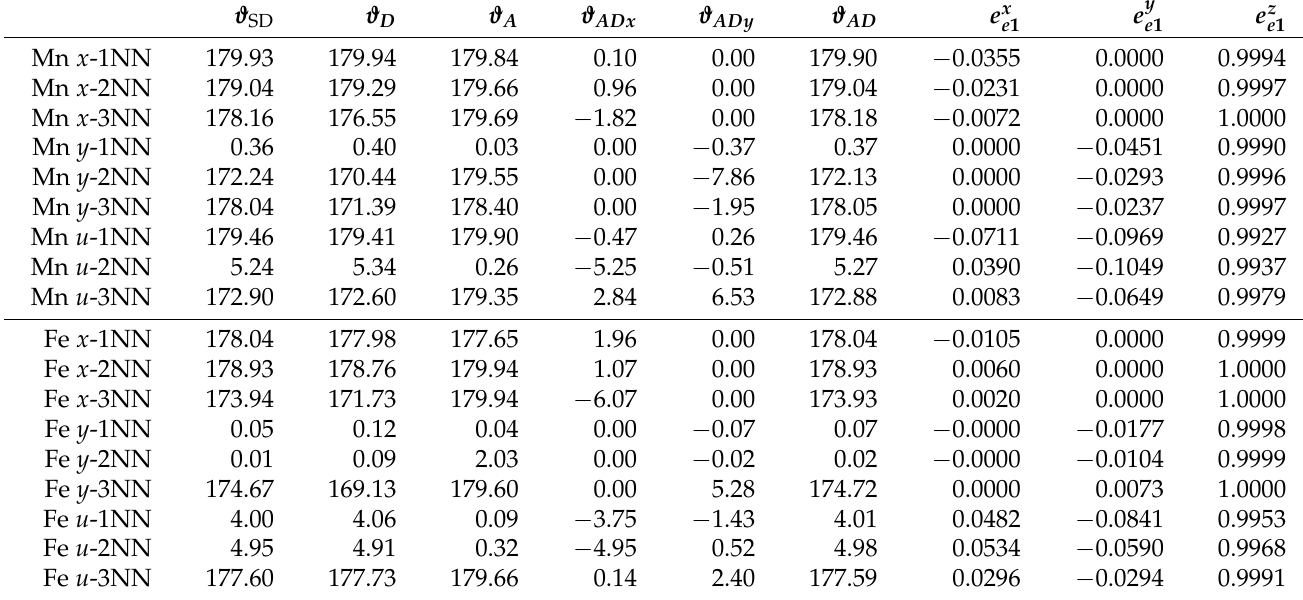
Table A1. Ground state spin angles in degree units from SCE spin model of Mn and Fe dimers. The easy direction unit vector components are given for the first spin, which always has smaller x or y coordinate. The direction on the second spin may be obtained by a C 2 rotation. ϑ SD is obtained from numerical spin dynamics calculations; the other angles represent different levels of approximations discussed in Appendix